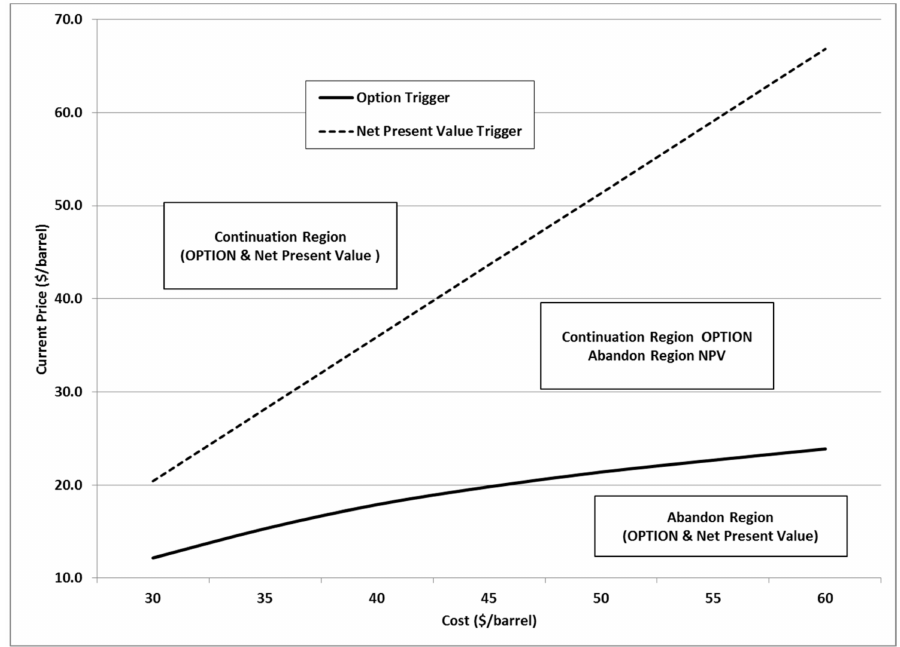
Figure 7. Abandonment Option: Exercise/Continuation Regions and Profit/Loss Regions.